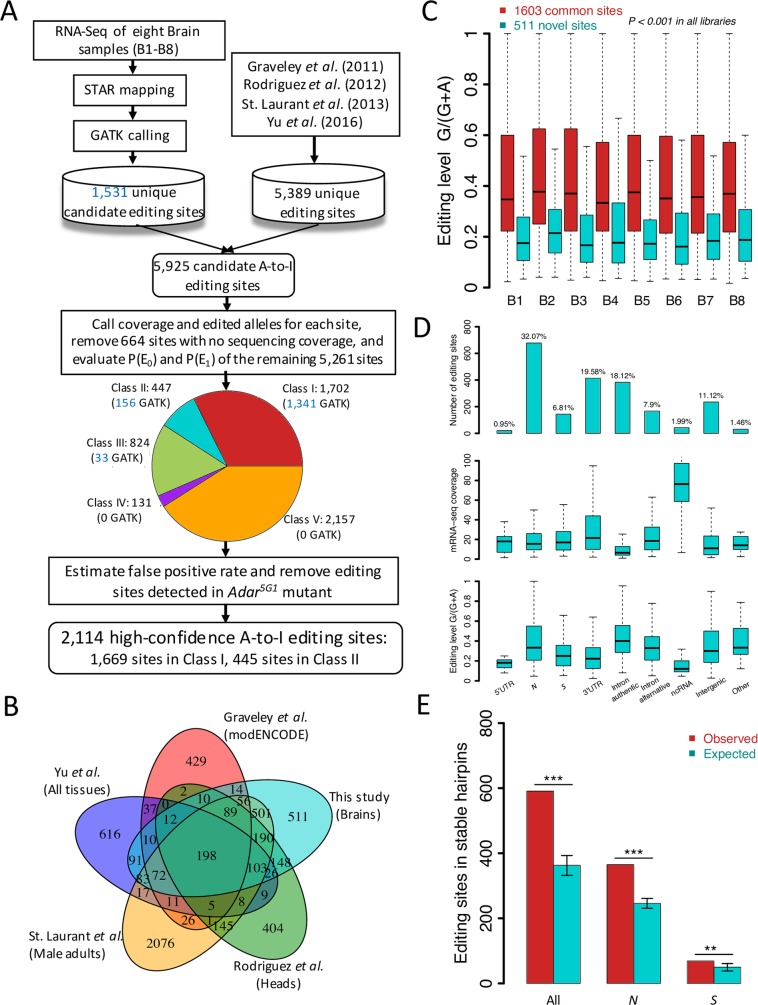
The landscape of A-to-I editomes in D. melanogaster.(A) A flowchart of A-to-I editing detection in brains of D. melanogaster. Editing sites are classified into five distinct classes based on the decreasing confidence of editing, sequencing coverage, and the number of libraries in which the editing events are detected. (B) Overlaps of the editing sites identified in this study and previous studies. (C) Boxplots of the editing levels of the common and novel sites in each brain library (P < 0.001 in each brain library, KS tests). (D) A summary of the editing sites with respect to their functional annotations. The numbers of high-confidence editing sites in each functional category in D. melanogaster are given in the top panel, and the proportion of editing sites is presented above the bars. mRNA-seq coverage (middle) and editing level (bottom) of editing sites in each category are also shown. For a site, the median value of coverage and editing level across all the libraries (if applicable) is used for the boxplots. (E) The observed numbers of editing sites located in stable hairpin structures and the expected numbers of sites (median and 95% confidence intervals) under randomness. ***, P< 0.001 revealed by simulations.